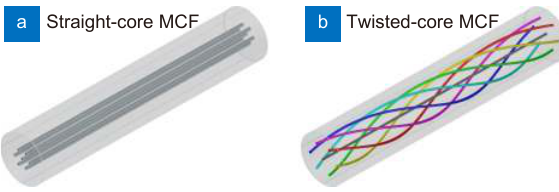
Fig. 1 | 7-core MCFs with straight ( a ) and twisted ( b ) side cores.